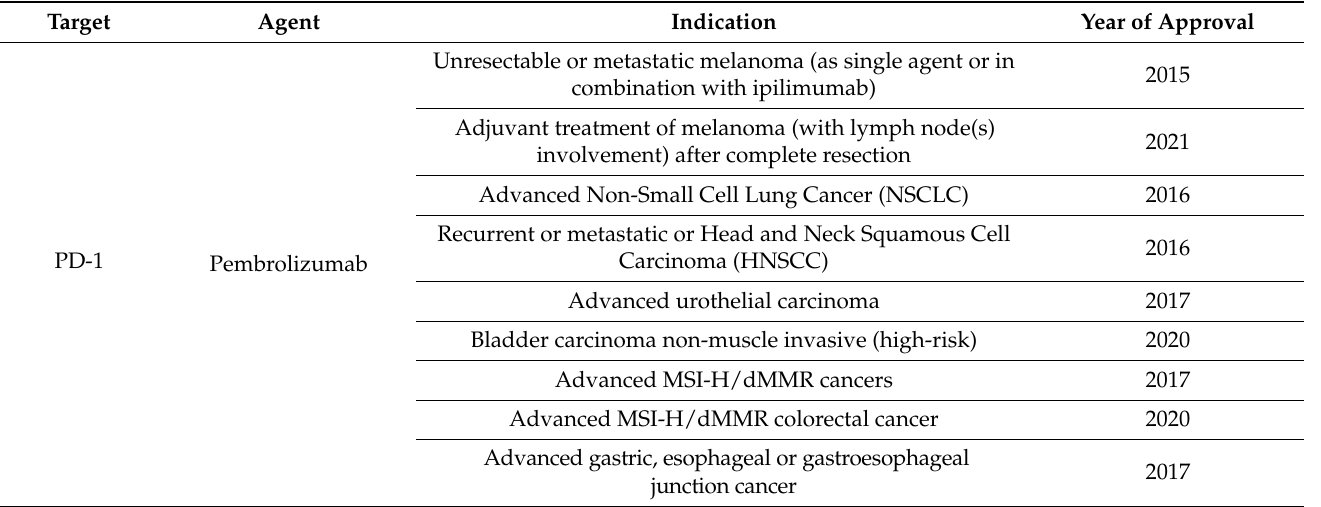
Table 1. ICIs approved by